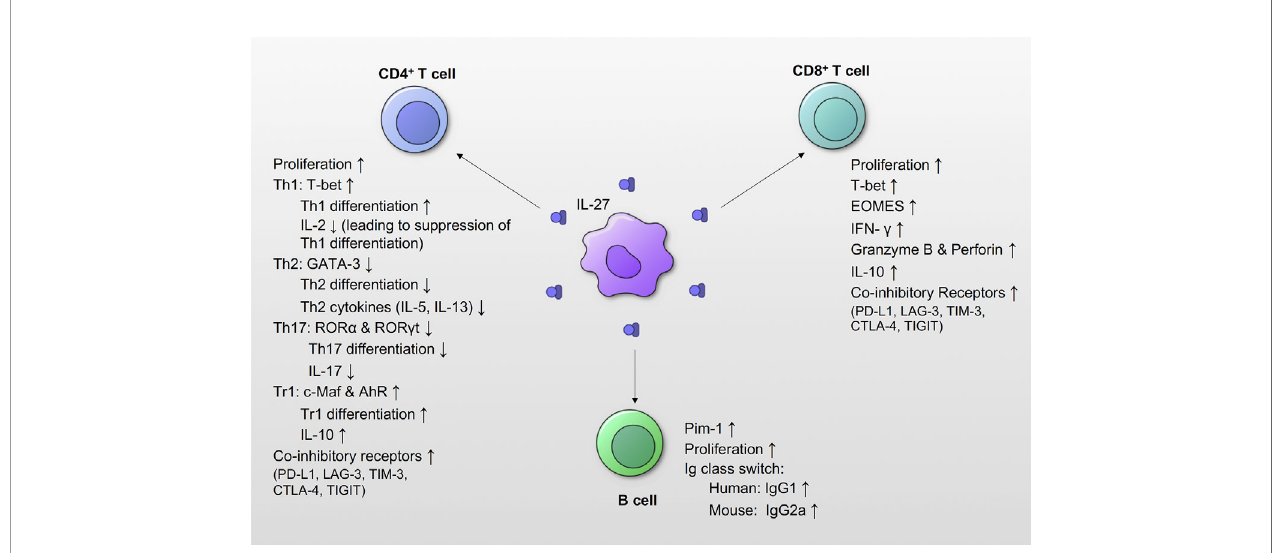
FIGURE 4 | Effects of IL-27 signaling on adaptive immune responses. IL-27 signaling promotes proliferation of CD4 + T cells, CD8 + T cells and B cells. IL-27 promotes expression of the T-bet, and induces Th1 differentiation by increasing the expression of IL-12R b . However, subsequent IL-27signaling suppresses the production of IL-2, which leads to suppression of Th1 differentiation. IL-27 also suppresses the transcription factors GATA-3 and ROR, as well as Th2 and Th17 differentiation and function. IL-27 signaling induces Tr1 differentiation from T cells, and increases IL-10 production. IL-27 induces co-inhibitory receptors, and suppresses activated effector T cells. IL-27 also increases the expression of transcription factors T-bet and EOMES in CD8 + T cells, and increases production of IFN- g , granzyme B and perforin. IL-27 also increases the production of IL-10 in CD8 + T cells. IL-27 increases the expression of Pim-1, which is a gene associated with cell proliferation and survival in B cells. IL-27 also induces IgG class switching. In humans, IL-27 increases IgG1, and IL-27 increased IgG2a in